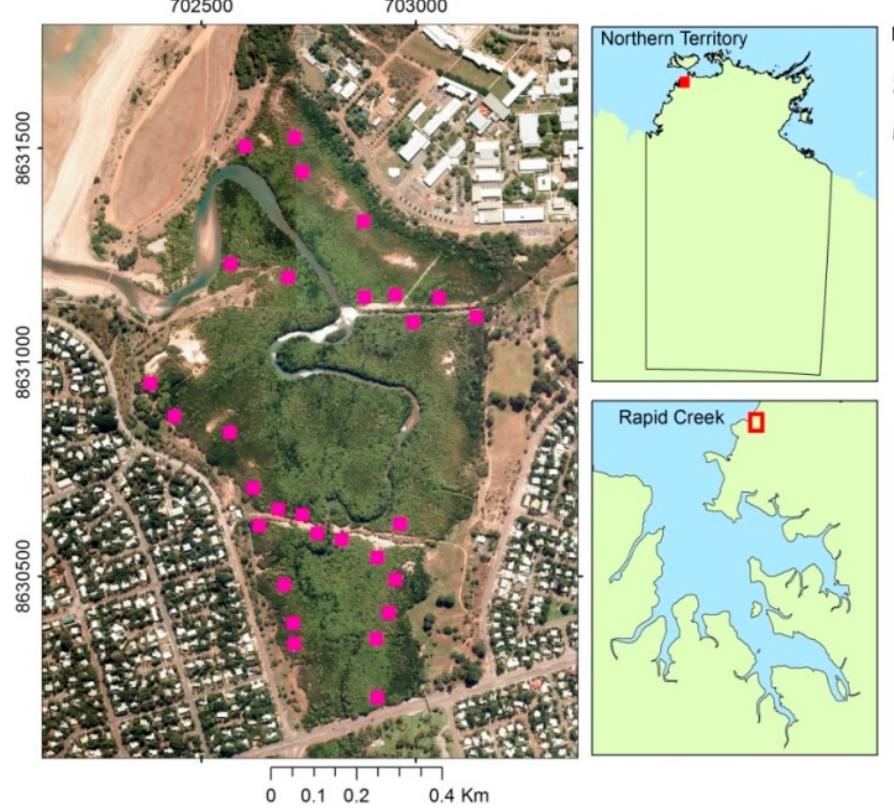
Figure 1. Rapid Creek coastal mangrove forest, Darwin, Northern Territory, Australia. The distribution of field sampling plots (5 m × 5 m) is shown in the map (the sizes of magenta squares are not to the scale). Aerial photographs © Northern Territory